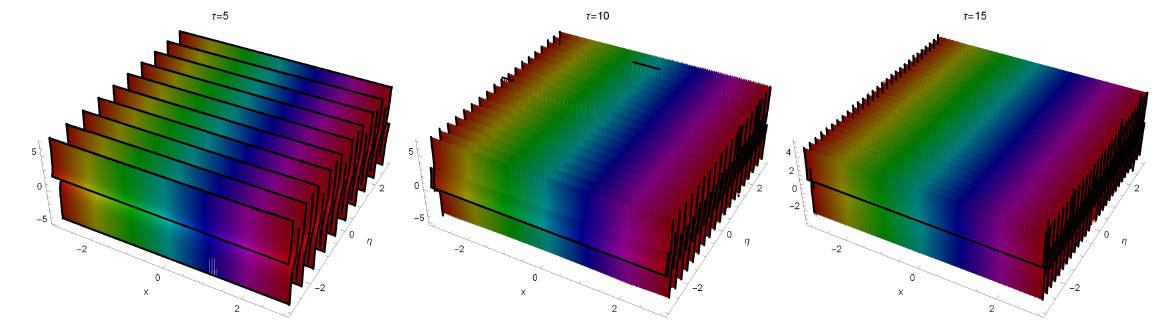
Fig. 6. The solution w 8 ( x , y , t ) for σ = 5.1, µ 1 = 0.6, µ 2 = 0.2, µ 3 = 0.2, α 0 = 1, β 1 =